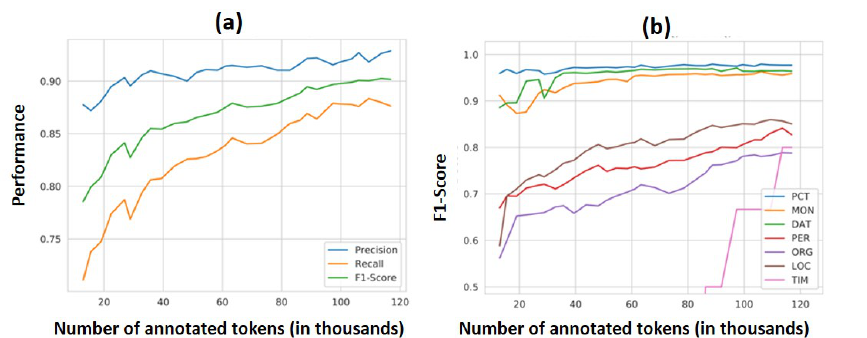
Figure 4. ( a ) Overall performance (F1-score) during the first 30 iterations during model training according to the settings of the reference experiment, i.e., with manual annotation of 20 sentences from the lowest quantile and 20 from the quantile 0.2 upwards (‘Ann. 20-0Q, 20-0.2Q; ST’ in Table 3). ( b ) Model performance for each separate entity